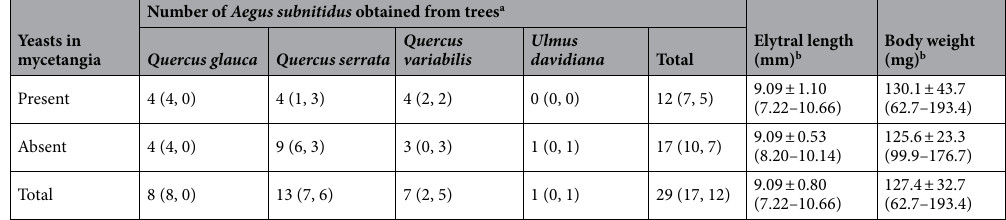
Table 1. Aegus subnitidus examined in this study. a Numbers of sexually immature and mature individuals are in parentheses, respectively. b Mean ± SD